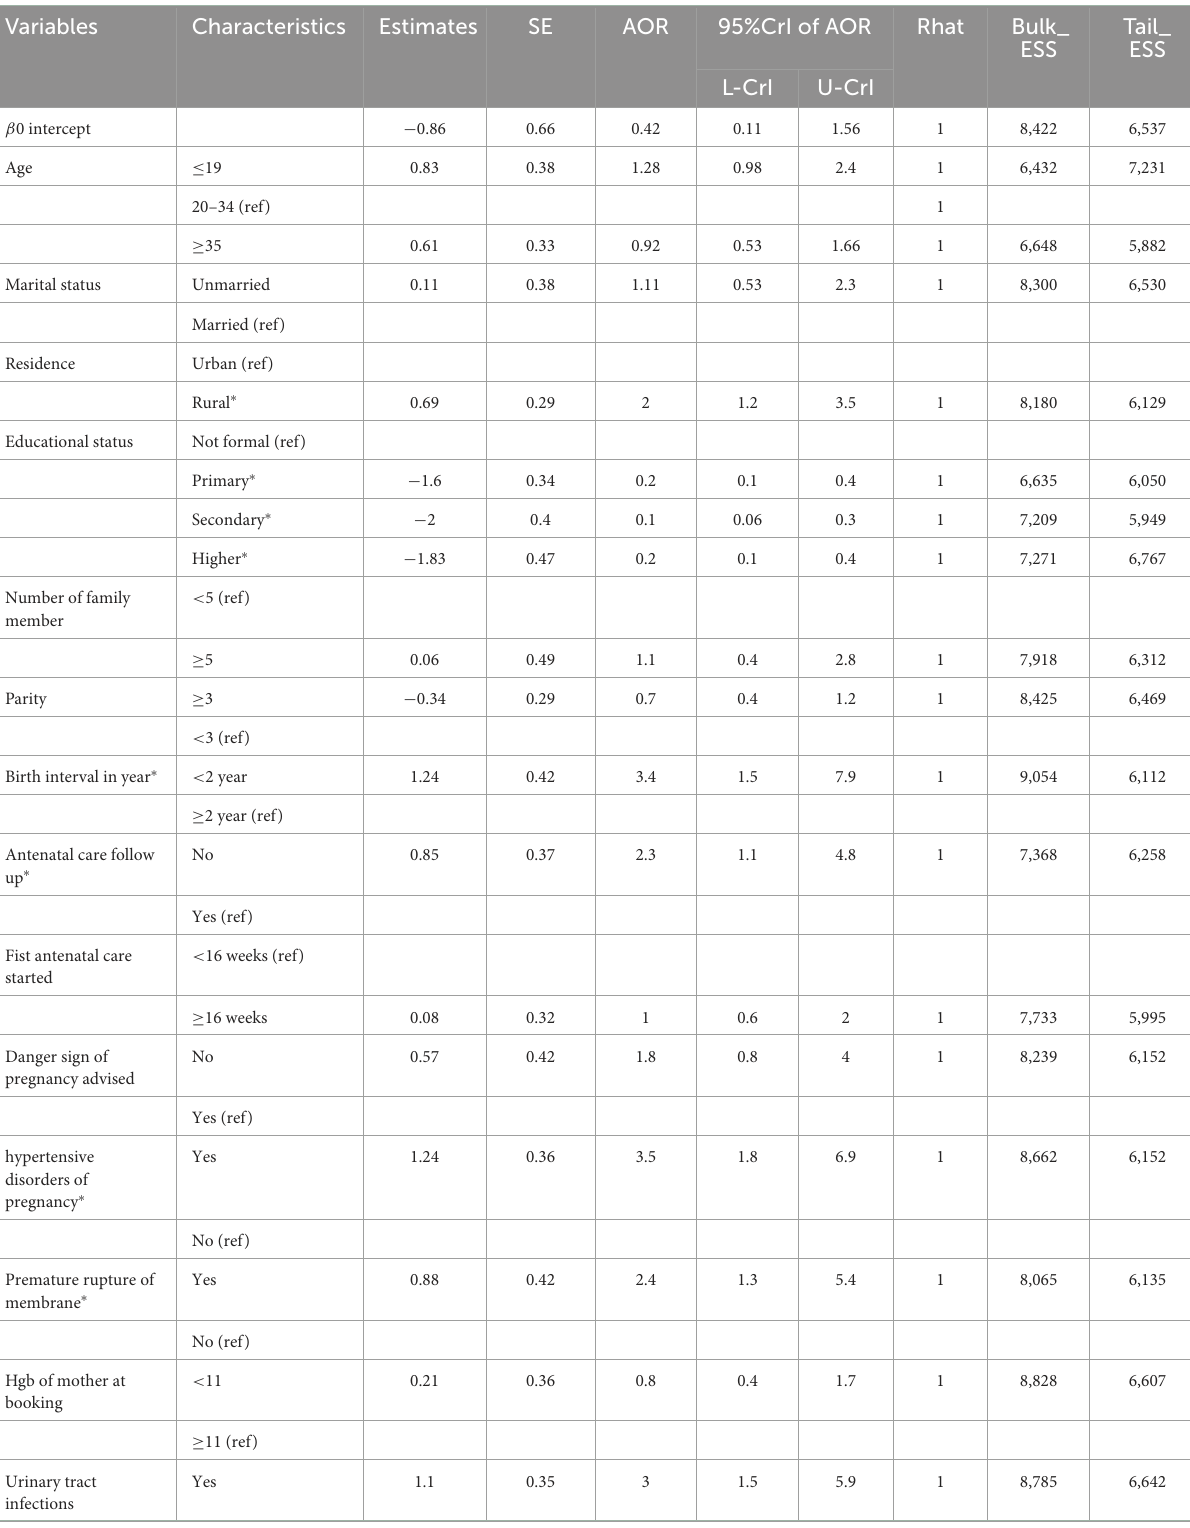
TABLE 2 Relationship analysis for preterm birth and predictors based on the Bayesian approach in Southeast Ethiopian women in 2020.